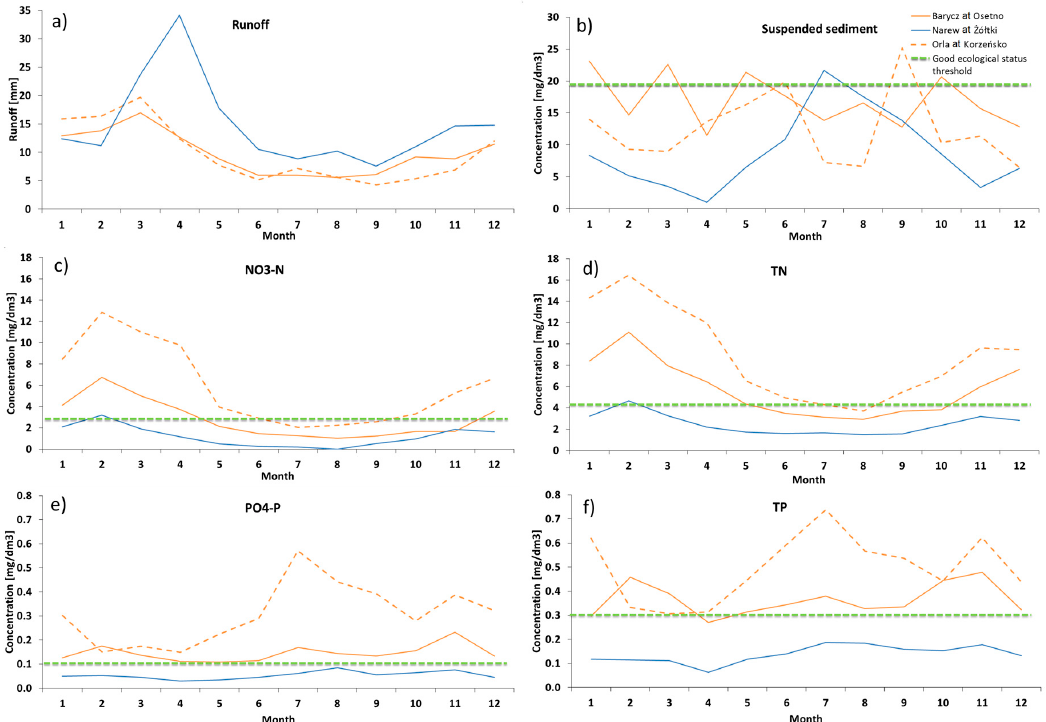
Figure 2. Mean monthly statistics of hydrological and water quality parameters for two stations (cf. Figure 1 for location) in the Barycz catchment (the Barycz river at Osetno and the Orla river at Korze ń sko) and one in the Upper Narew catchment (the Narew river at Ż ó ł tki): ( a ) runoff; ( b ) sediment concentration; ( c ) NO 3 –N; ( d ) TN; ( e ) PO 4 –P; and ( f ) TP. Joint period of flow data (source: